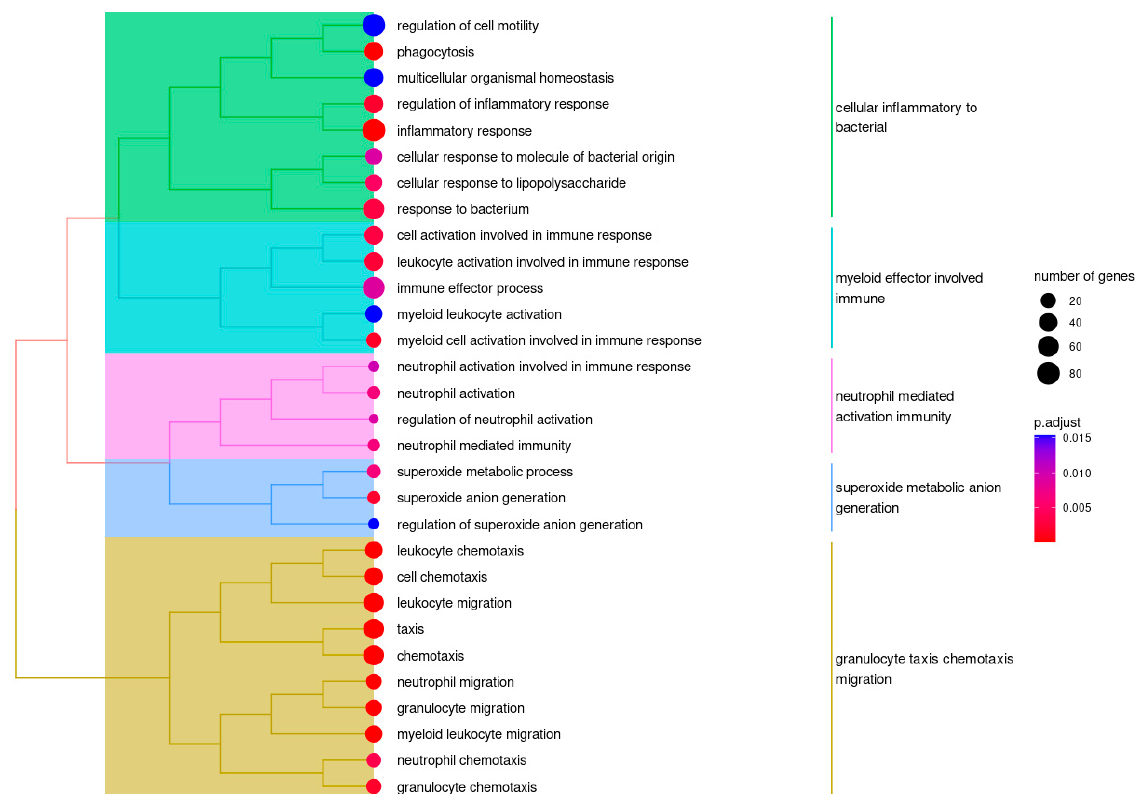
Figure 1. Hierarchical clustering of significantly overrepresented GO terms in module brown. Semantic cluster tags are given to the right of each cluster. Most GO terms are related to immune processes. We believe this signi fi es immune system abnormalities and is a re fl ection of the blood phenotype of FASD, which is characterized by an increased risk of infections.